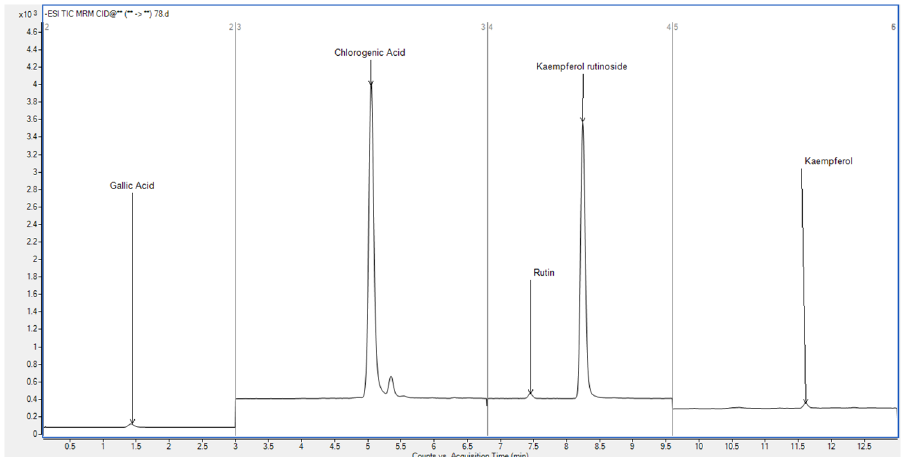
Figure A1. LC-MS profile of individual polyphenol compounds of spray-dried tamarillo powder. The run is divided to different segments for different